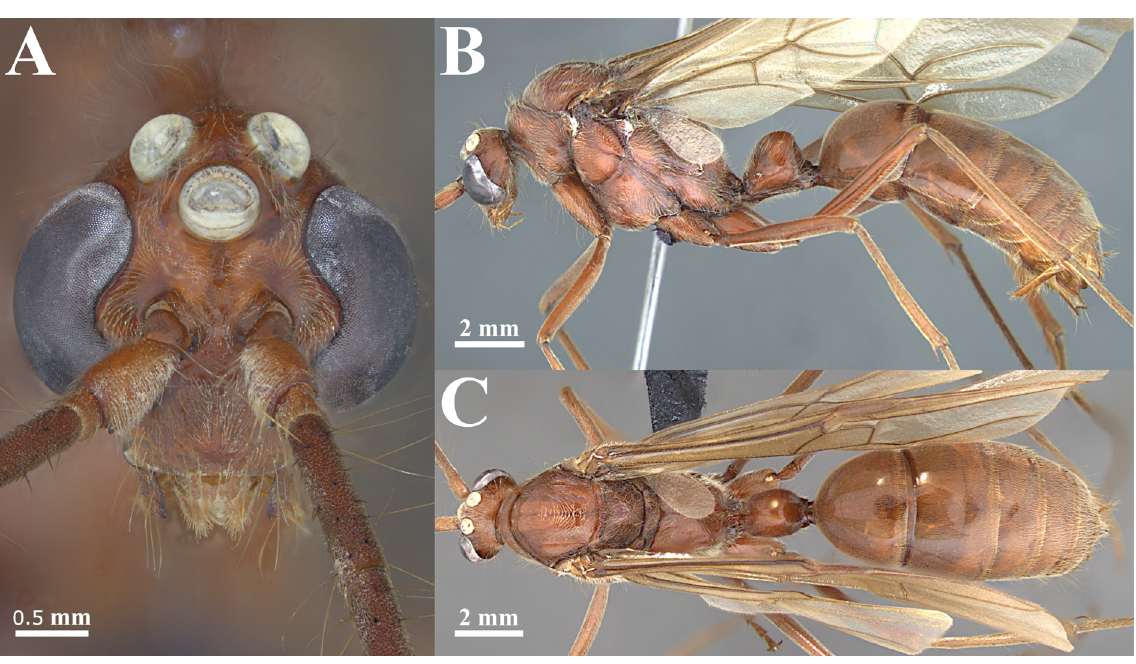
Fig. 26. Dinoponera quadriceps Kempf, 1971, ♂ (specimen from Caracol, Piauí, Brazil; DZUP 549804). A . Full-face view. B . Full body in lateral view. C . Full body in dorsal